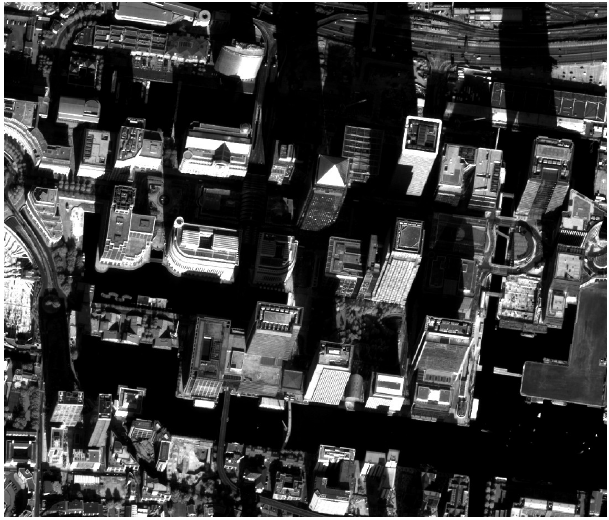
Figure 7: Satellite image data - inner city of London (Canary